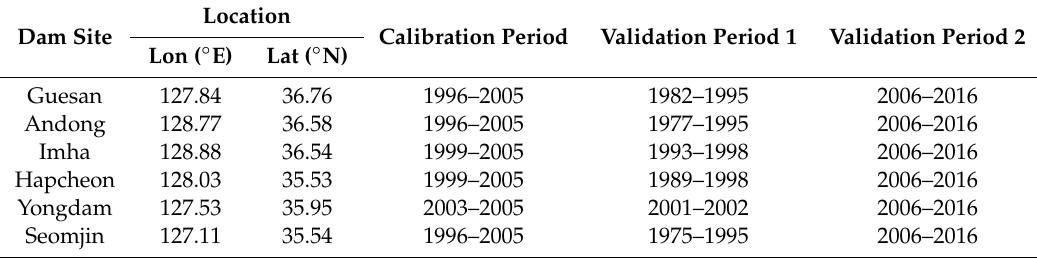
Table 2. Information on dams and calibration and validation